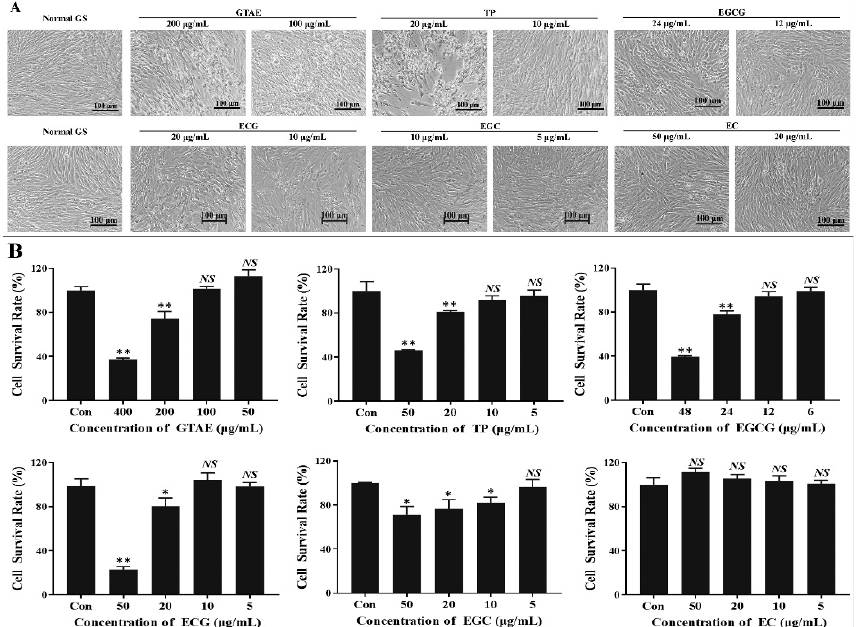
Figure 2. Determining the working concentrations of green tea components. ( A ) Grouper spleen (GS) cells were incubated with different concentrations of green tea components for 48 h and then observed with light microscopy. Morphological changes were observed in the GS cells incubated with green tea aqueous extract (GTAE), TP (tea polyphenols), epigallocatechin-3-gallate (EGCG), epicatechin gallate (ECG), epigallocatechin (EGC), and epicatechin (EC). ( B ) Cell survival analysis with CCK-8 solution: GS cells were incubated with different concentrations of green tea components. The results of comparisons with p < 0. 05 were considered to represent statistically significant differences (* p < 0. 05, ** p < 0. 01, NS is no significant difference.). The same below.